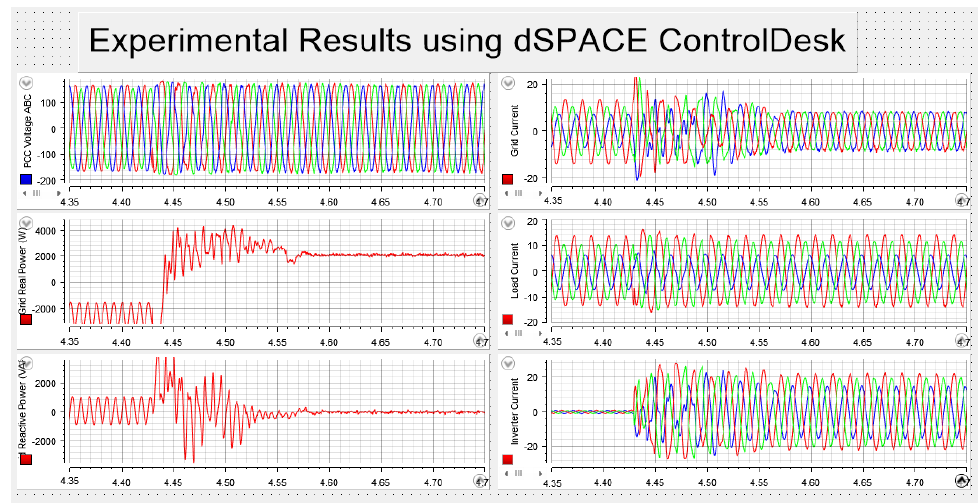
Figure 13. Experimental results at P = 2 kW, Q = 0 var using dSPACE Control desk.